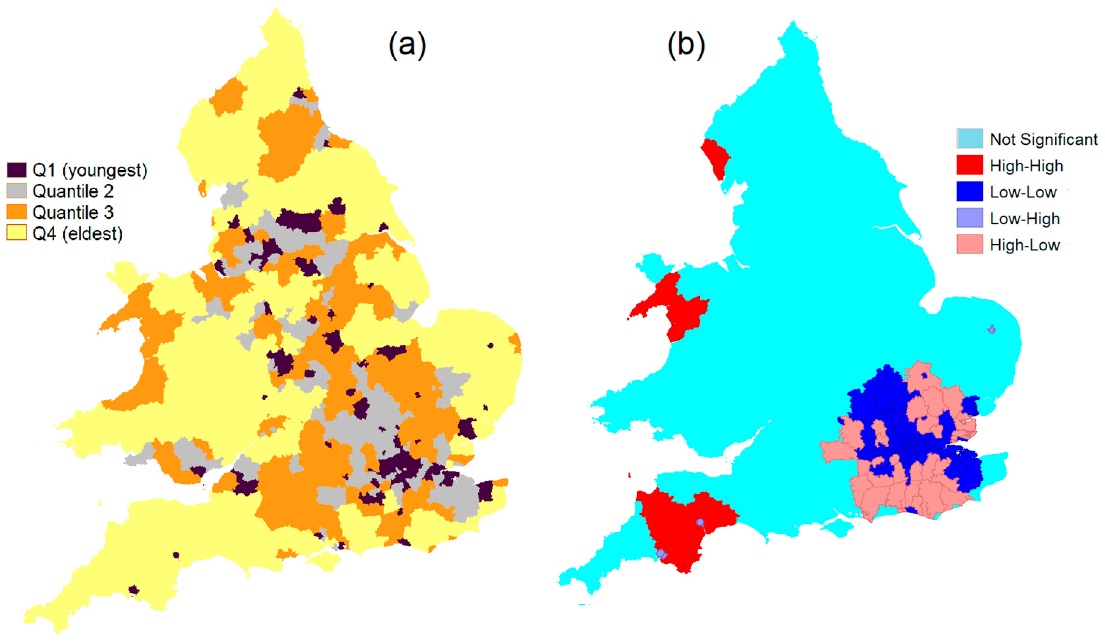
Figure 1. Age Distribution. ( a ) is a map displaying age by quantiles. ( b ) is a map of local indicators of the spatial association of the same